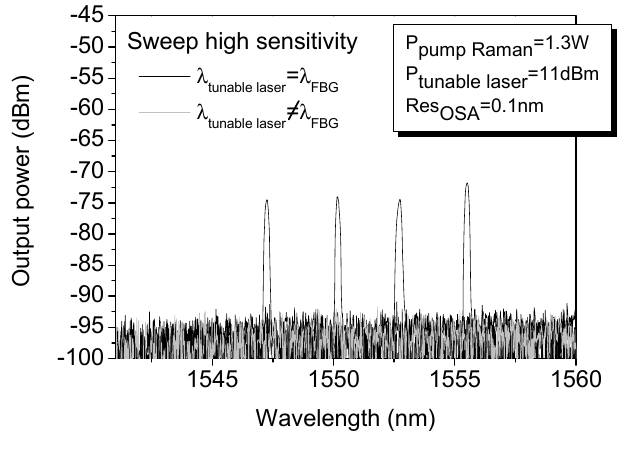
Figure 9. Spectrum of the reflected signal from the four FBG using OSA option sweep high